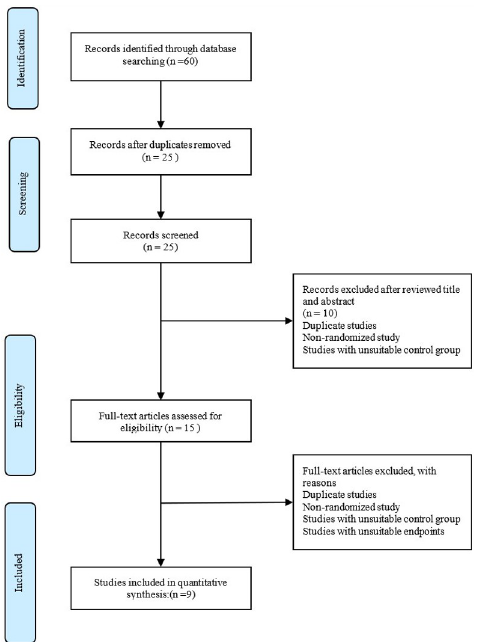
Fig 11. PRISMA flow diagram of literature search for health education intervention disaster preparedness among community in improving disaster preparedness among community.